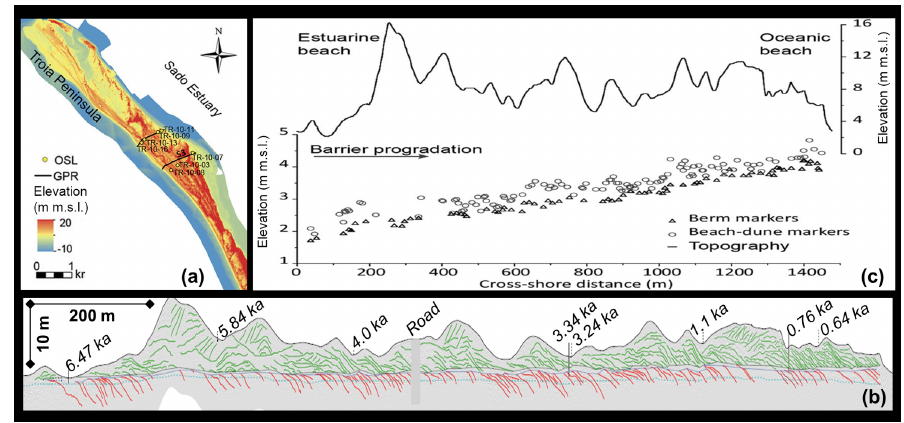
Figure 6. (a) Lidar of Troia Peninsula, Portugal, showing locations of GPR and OSL transects. (b) GPR transect across the barrier showing interpreted dune stratigraphy in green and beachfaces in red, with associated OSL ages. (c) Elevation plot of berm and beach-dune markers used as a sea-level proxy displayed with corresponding overlying dune morphology. Figure modified from Costas et al.